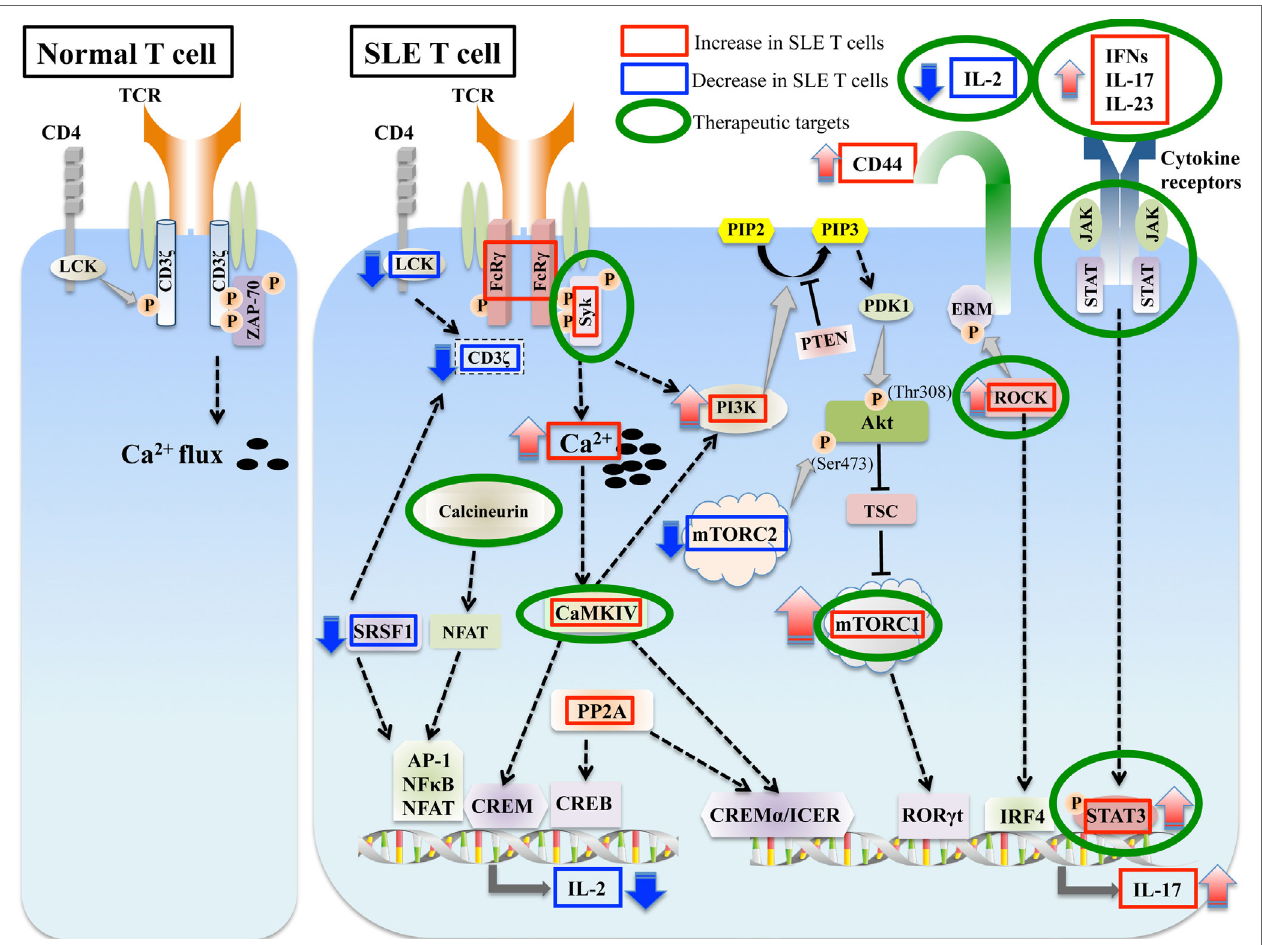
FigURe 1 | Aberrant signaling in systemic lupus erythematosus (SLE) T cells. SLE T cells are characterized by multiple aberrant signaling pathways, such as decreased CD3 ζ , activated PI3K-Akt-mTORC1 pathway, Rho associated protein kinase (ROCK), calcium/calmodulin kinase IV (CaMKIV), and protein phosphatase 2A (PP2A). These are associated with abnormalities in T cell differentiation and production of proinflammatory cytokines such as IL-17 and decreased production of vital cytokines such as IL-2. Molecules aberrantly increased or decreased in SLE are indicated in red and blue boxes, respectively, and molecules that are potential therapeutic targets are in green